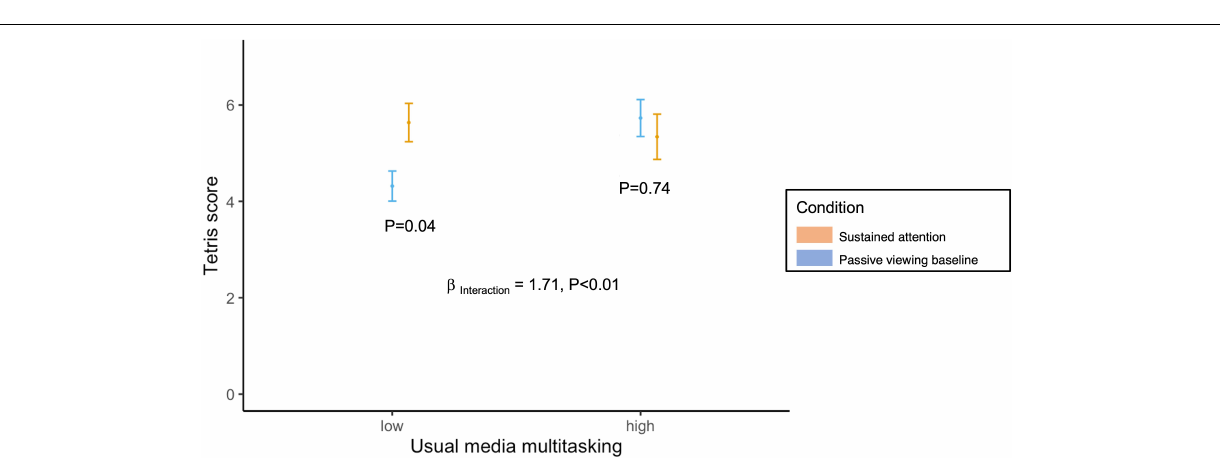
FIGURE 3 | Tetris performance in the presence of distractors following completion of the sustained attention and passive viewing conditions by usual media multitasking (dichotomized at the median). Data presented as mean ± 1.96 × SEM. P Interaction : Mixed effect model, nested within participant, predicting Tetris score from condition coded as binary (0 = control; 1 = sustained attention), usual media multitasking coded as a continuous predictor, and a multiplicative interaction between the